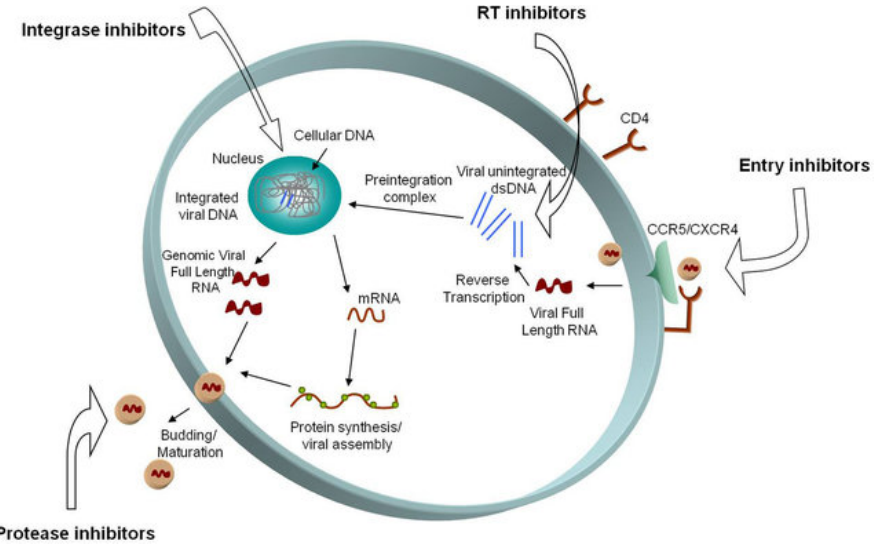
Fig. 2. Depiction of HIV life cycle with entry, protease, RT, and integrase inhibitor drug